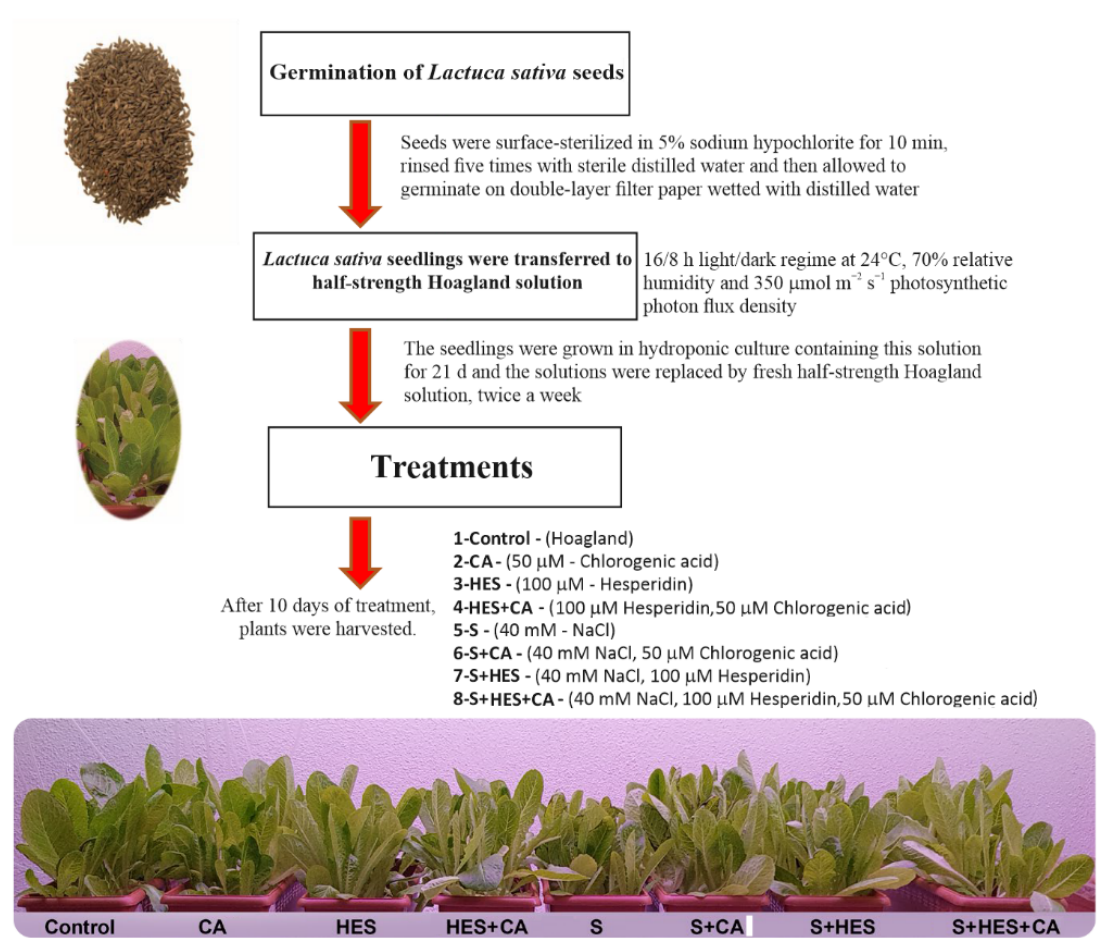
Figure 5. Workflow and experimental design of the germination, growth, and treatment of the seeds of Lactuca sativa L. Abbreviation: CA: Chlorogenic acid; HES: Hesperidin; S: Salt.